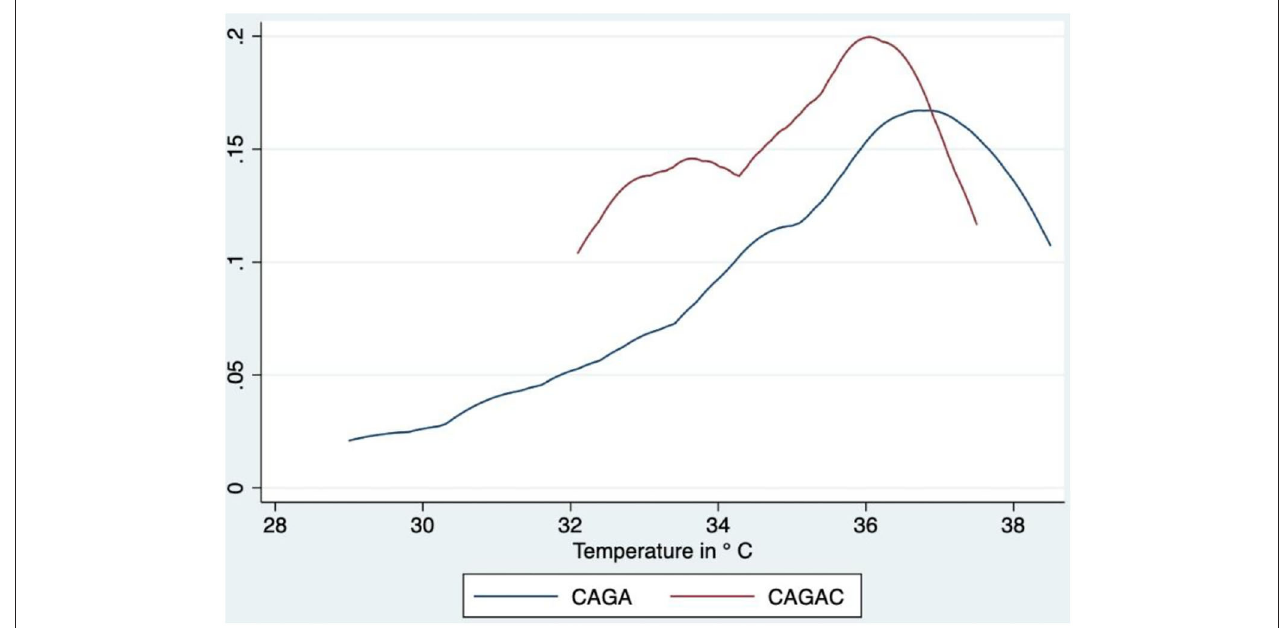
FIGURE 2 | Comparative analysis of probability density functions—TA. CAGA, circumanal gland adenoma; CAGAC, circumanal gland adenocarcinoma.